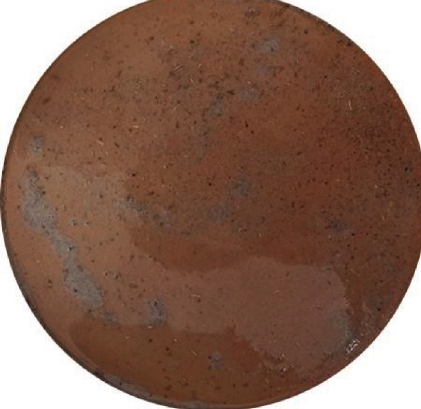
Figure 1: Soil sample.